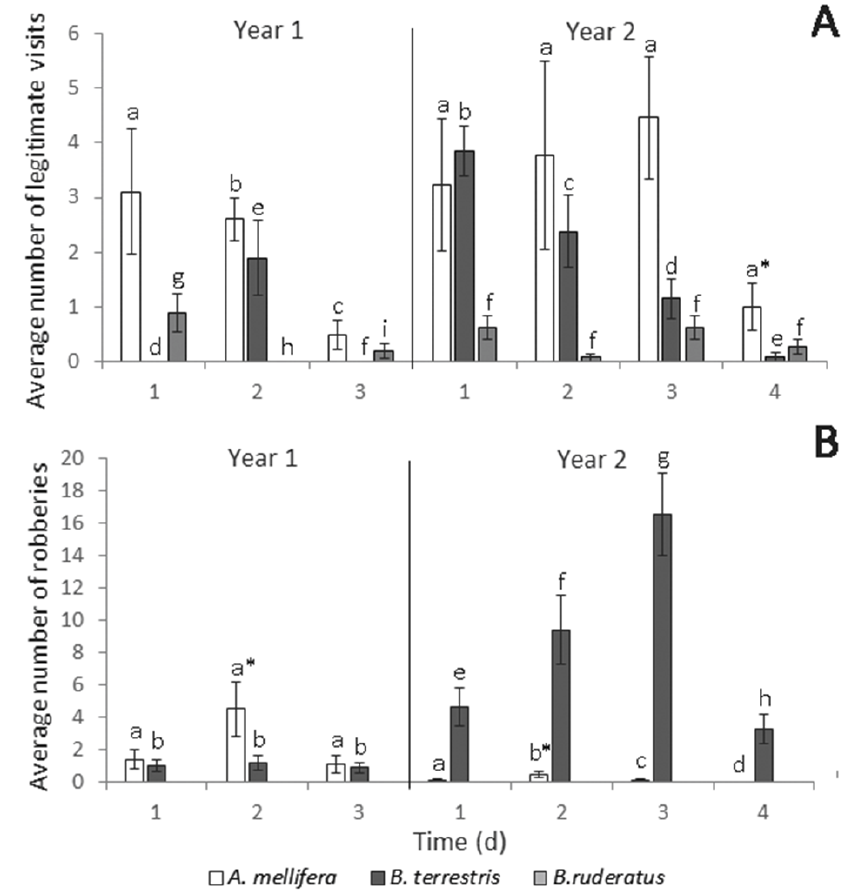
Figure 2. Average absolute number (± standard error) of (A) legitimate visits and (B) nectar robbery events by Apis mellifera, Bombus terrestris and B. ruderatus on open flowers of Vicia faba during each day of flower life in both study years (recorded by cameras). The same letters above bars mean there is no statistical differences, P < 0.05. Marginal p-values (between 0.05 to 0.1) are showed with an asterisk (*). Different letters mean significant